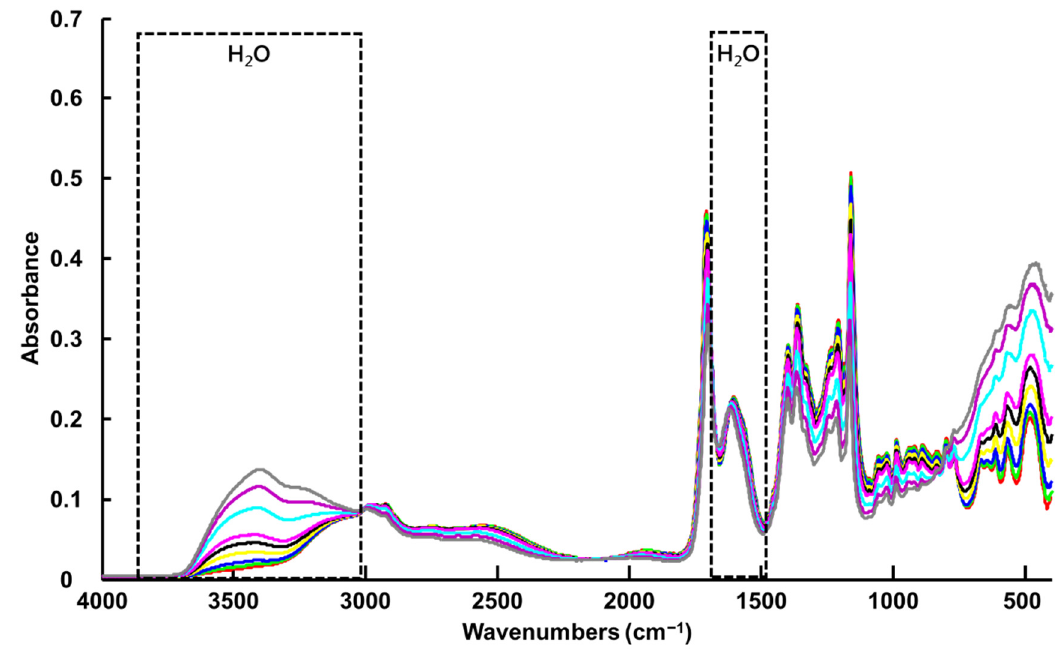
Figure 2. Mean raw ATR-IR spectra collected from LALP. Concentrations for added water (% w/w) are respectively ~ 0% (red), 0.99% (green), 2.4% (blue), 4.7% (yellow), 6.9% (black), 9.1% (magenta), 16.7% (cyan), 23% (purple) and 28% (grey).